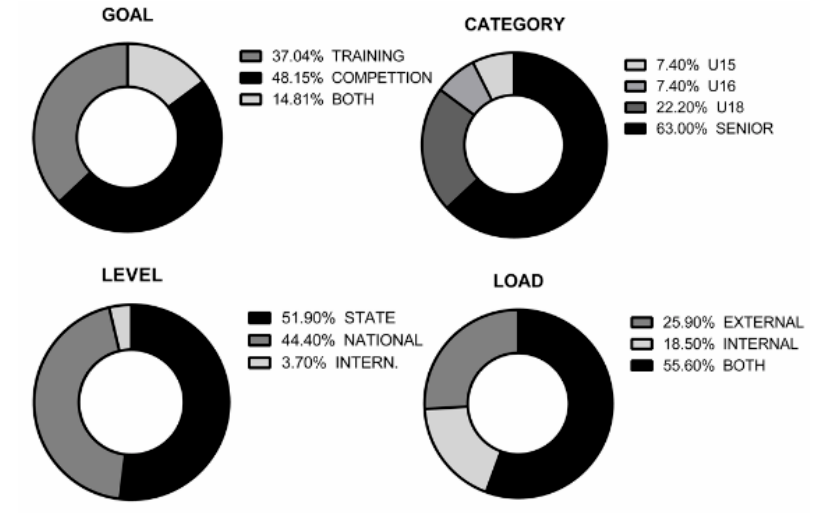
Figure 6. Distribution of the main variables.